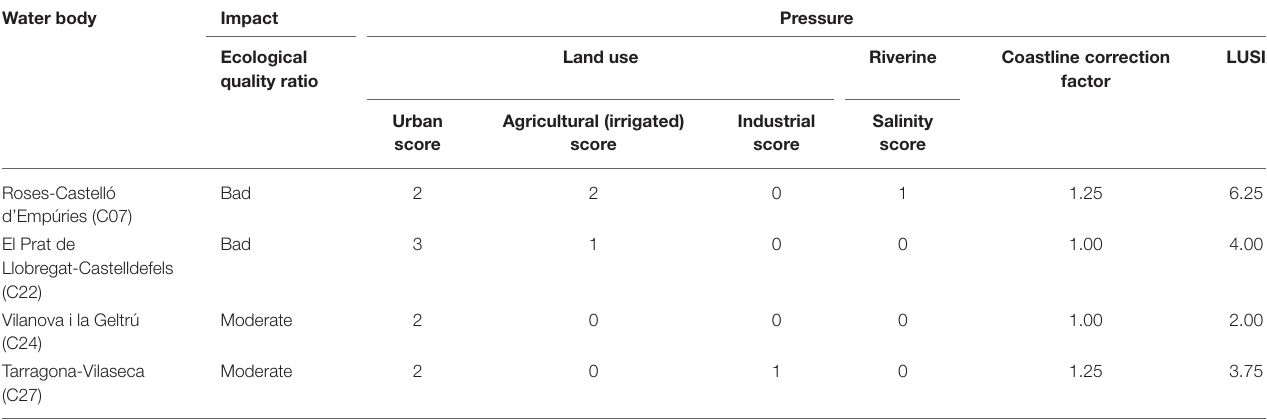
TABLE 7 | Impact and pressure of the water bodies of the catalan coast where impact has been demonstrated. Water